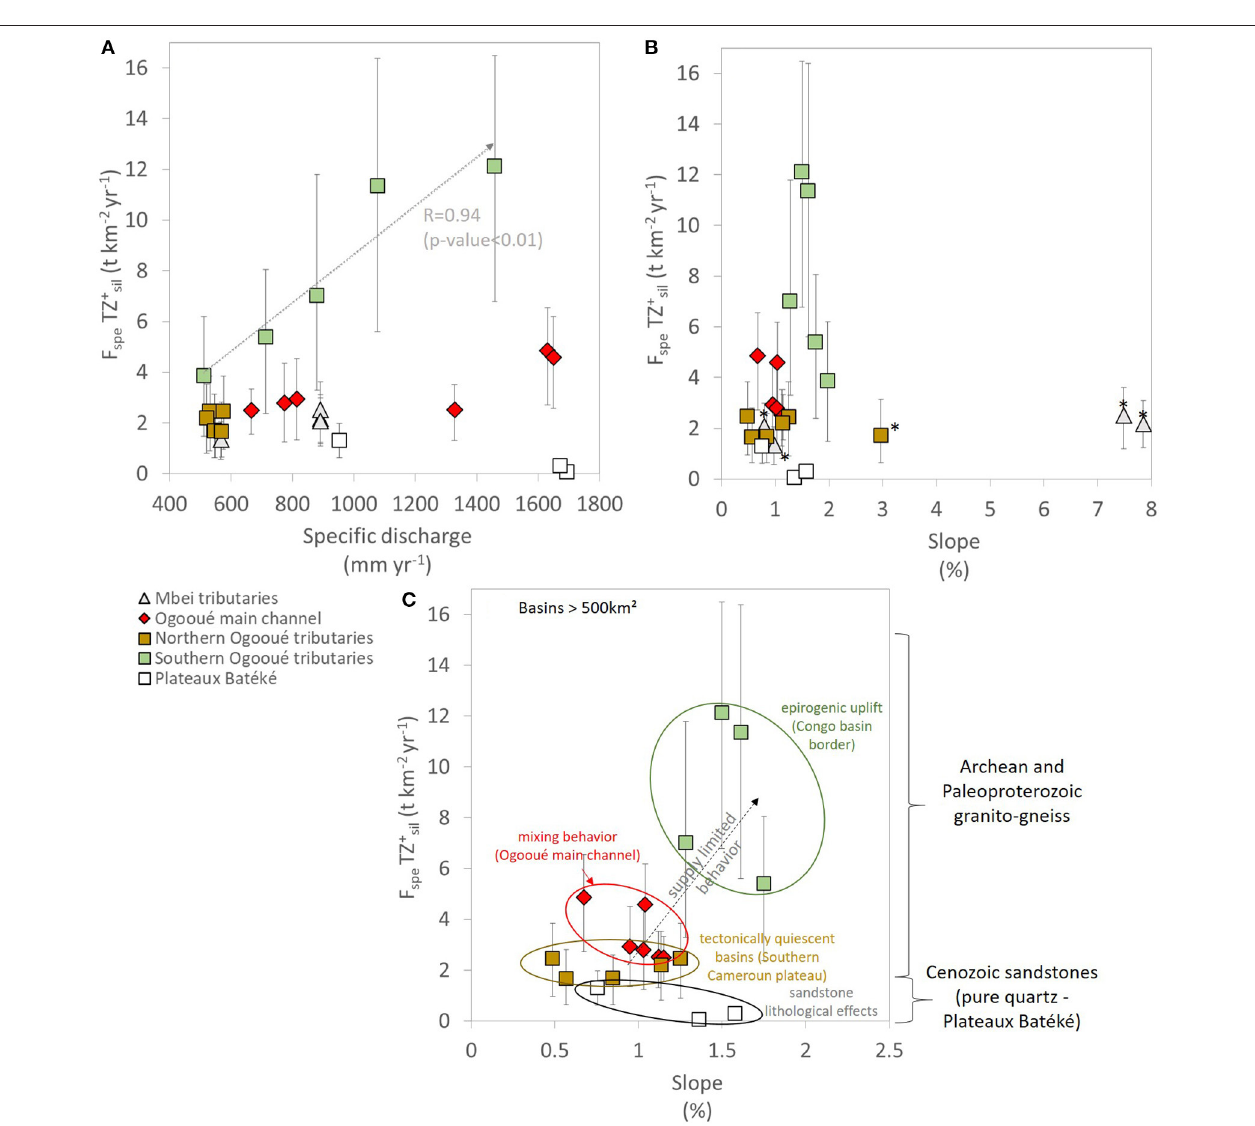
FIGURE 11 | Relationship between silicate weathering rate ( F spe TZ + sil in t km − 2 yr − 1 ) and (A) specific discharge and (B) mean basin slope in the Ogooué and Mbei basins. * correspond to the basins which exhibit NO − 3 concentration > 5 µ moles l − 1 . (C) Zoom on B only for basins with drainage area > 500 km ² . In panel A, the regression line is reported for Southern Ogooué tributaries for reference (R = 0.94; significant for p < 0.05). Error bars reflect uncertainties, the calculation of which is detailed in section Uncertainty